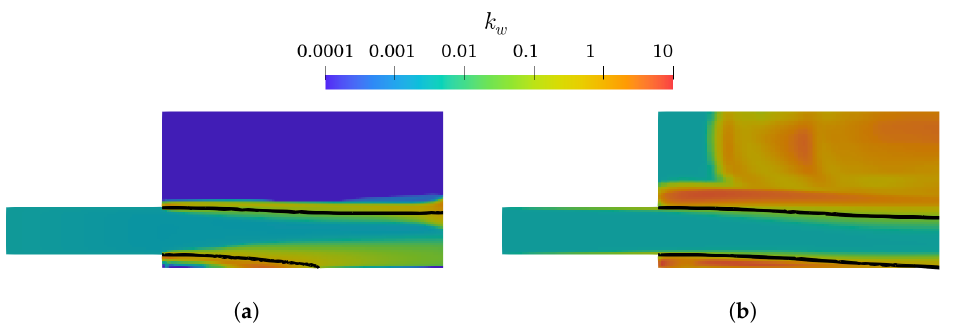
Figure 12. k w at vertical central plane of the CTPE model with R m = 20; interface ( α = 0.5, black line).